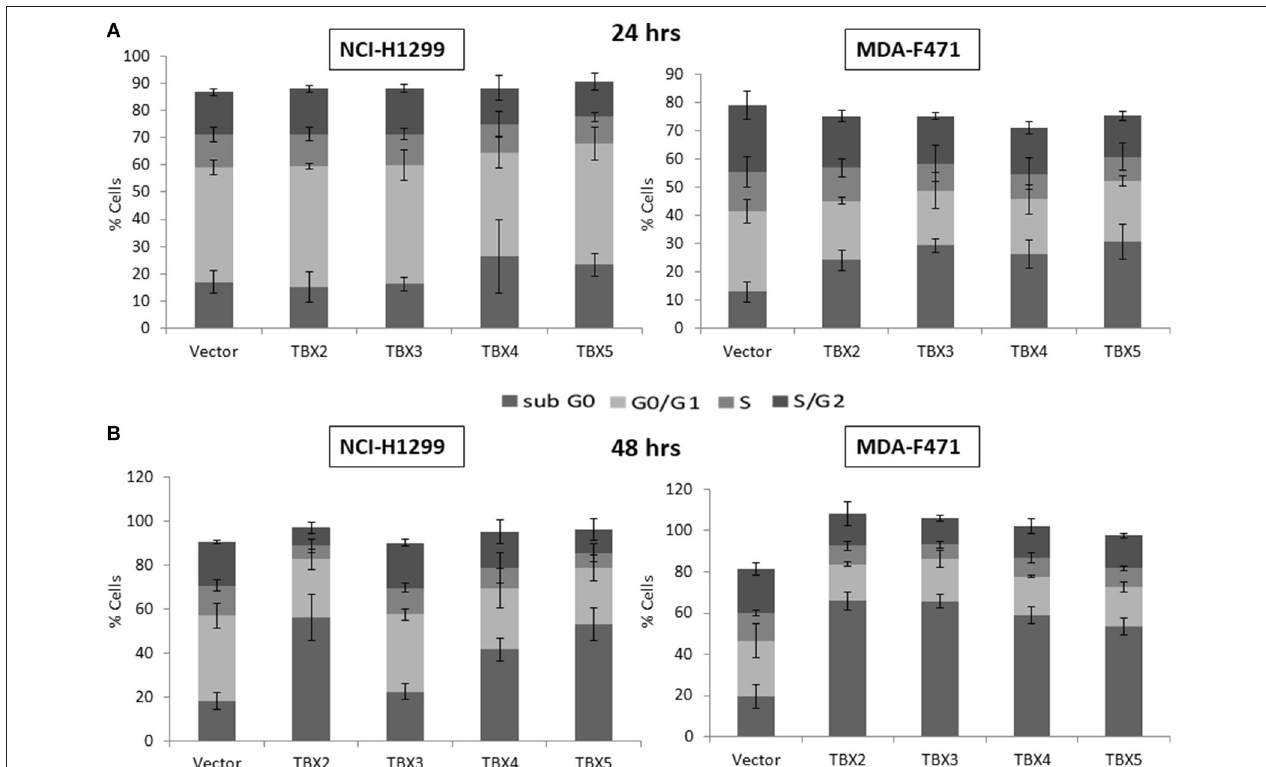
FIGURE 4 | Cell cycle analysis of NCI-H1299 and MDA-F471 cells overexpressing TBX’s. NCI-H1299 and MDA-F471 cells were transiently transfected with each TBX2 subfamily member encoding plasmid independently. After subsequent culture for 24 (A) and 48h (B) , cells were stained with propidium iodide PI and analyzed for DNA content by flow cytometry. The cell cycle arrests at sub-G0 phase as a result of this transfection. Results are representative of three separate experiments. Percentage of cells in each phase (subG0, G0/G1, S, or G2/M) are presented. Data represent the mean ±